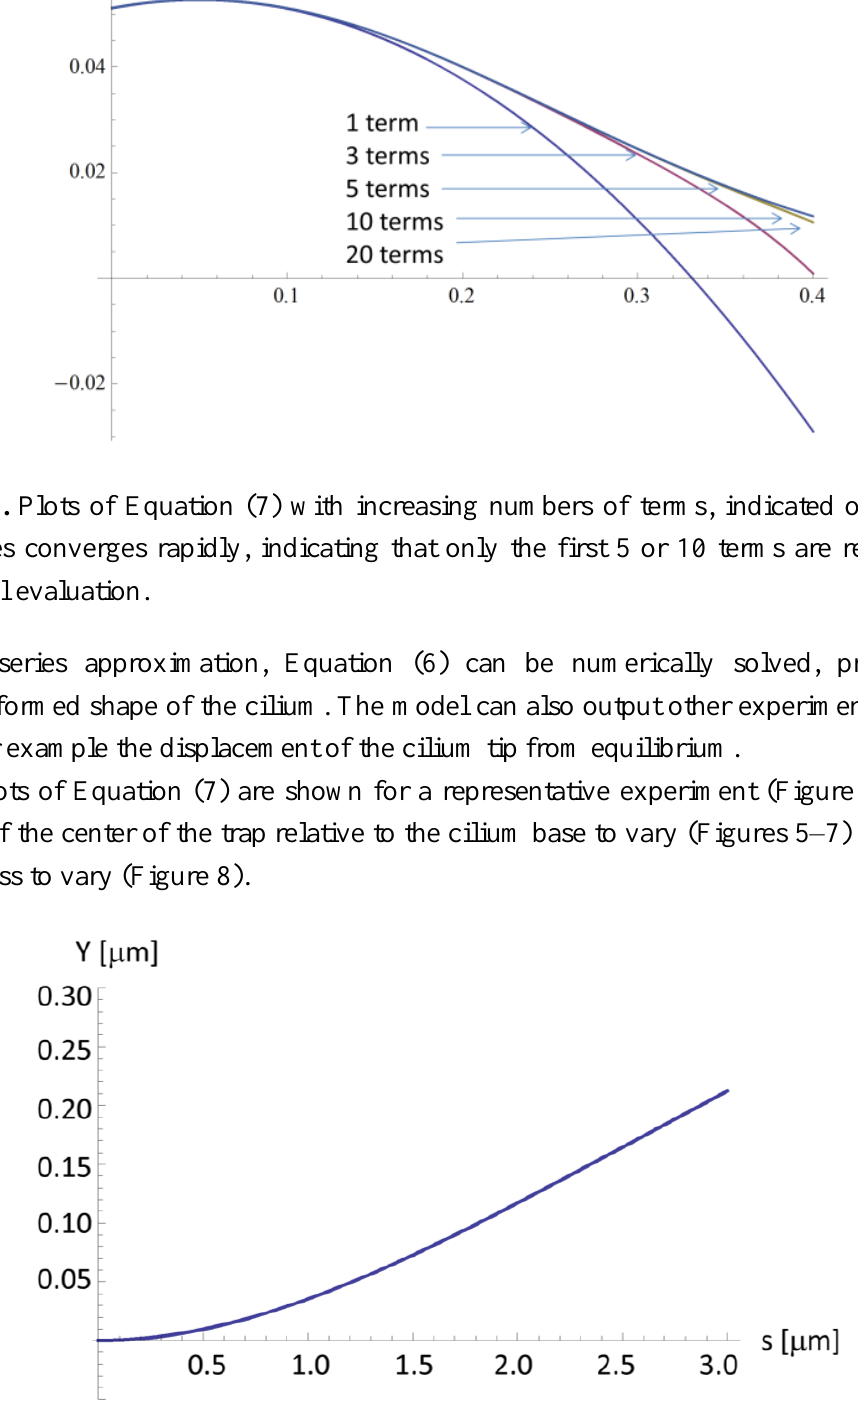
Figure 4. Example deformation of a primary cilium for a representative experiment. The trap parameters: incident power P = 0.5 W, trapping lens numerical aperture NA = 0.95, and trap wavelength λ 0 = 1.064 µm. The trap center was displaced from the cilium base by δy = 0.2 µm and δz = 2.5 µm. The cilium length is 3.0